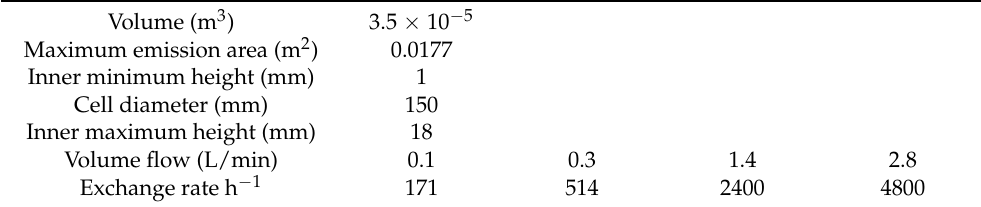
Table 1. Technical specifications of the FLEC [12].